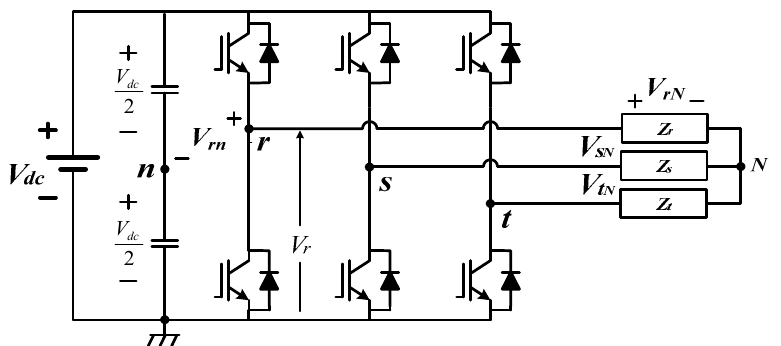
Figure 1. Circuit configuration of a 3-phase 3-leg inverter.